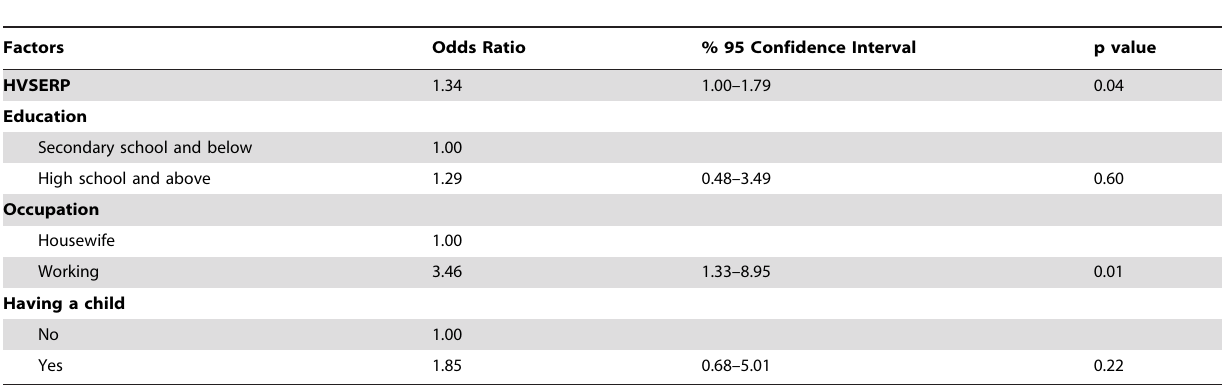
Table 3. Multiple logistic regression analysis of the independent variables affecting the decision of vaccination of pregnant